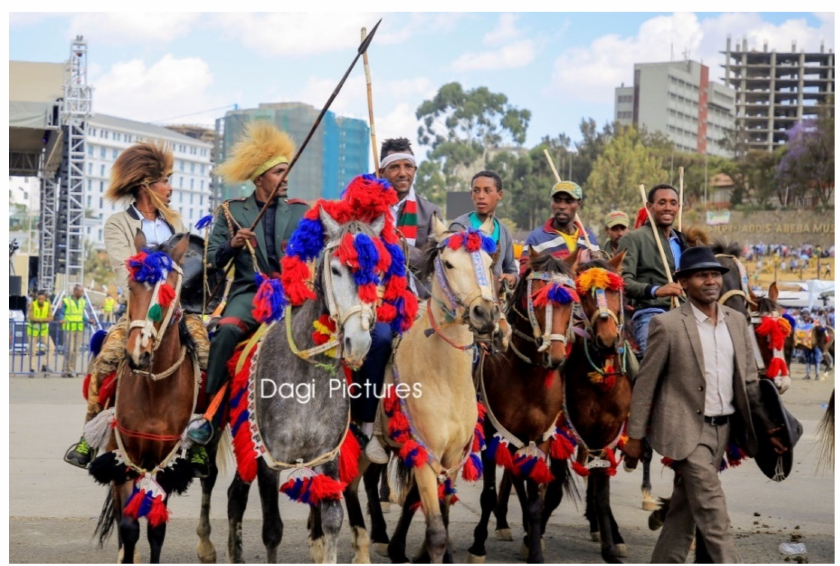
Figure 1. Horse parade to celebrate the 123rd anniversary of Adwa victory as led by prominent Ethiopian musician Hachalu Hundessa.